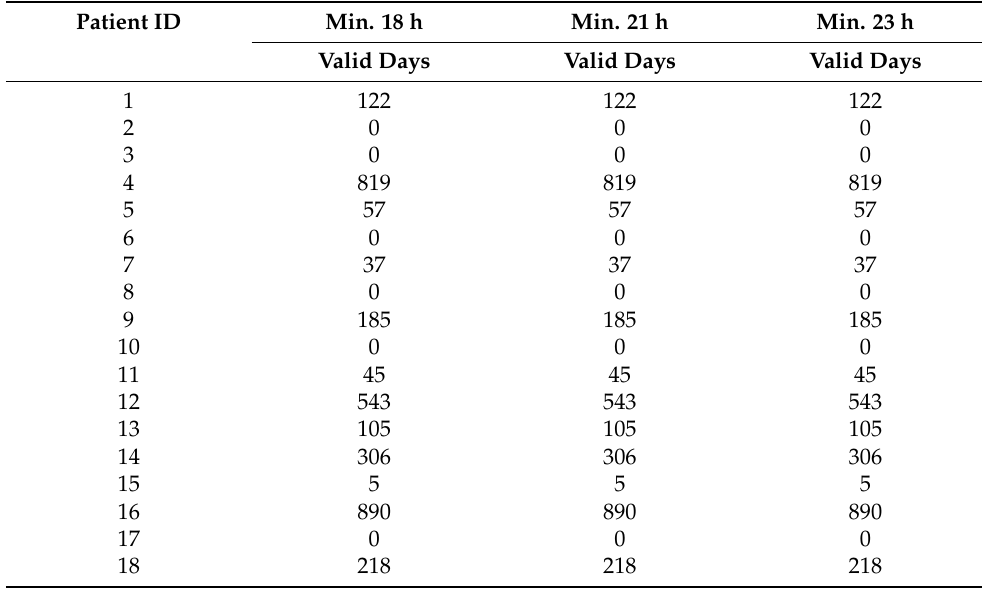
Table A3. Valid Fitbit days for day validation scenario type 1 (27